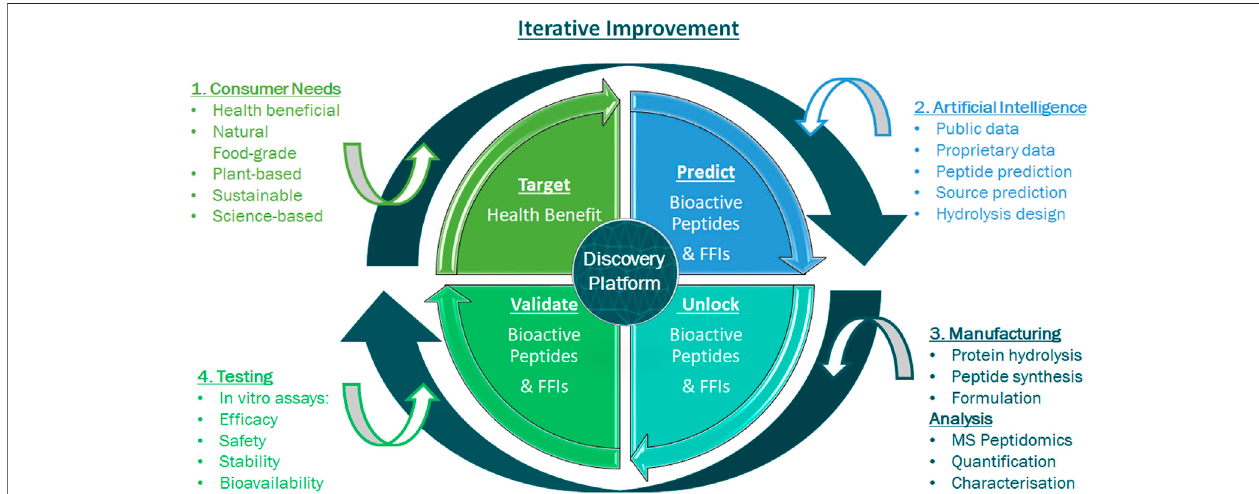
FIGURE 3 | Iterative feedback loop for an integrated discovery and validation of ef fi cacy platform. This consists of different technologies to explore the molecular diversity in plants and foods and create characterised natural, safe and effective health promoting bioactives for consumers. A number of processes are integrated in creating and characterising a functional food ingredient. 1) A consumer-driven health bene fi t is targeted. 2) The Arti fi cial Intelligence (AI) process begins with data curation,predictskeybioactivesandselectspreferredingredients.3)Predictedbioactivepeptidesandingredientsareunlockedandproduced.LC-MS/MSbased- peptidomics identi fi es and characterises the ingredients ’ peptide pro fi le. 4) Predicted peptides and ingredients are assessed for relevant bioactivity, safety and toxicity, aswellasforbioavailabilityusingsimulatedgastricintestinaldigestion (SGID)andinvestigationofstabilityinarelevanthumanmatrix,i.e.bloodplasma.Theoutputofthis integrated discovery platform is a characterised functional food ingredient that addresses an unmet health bene fi